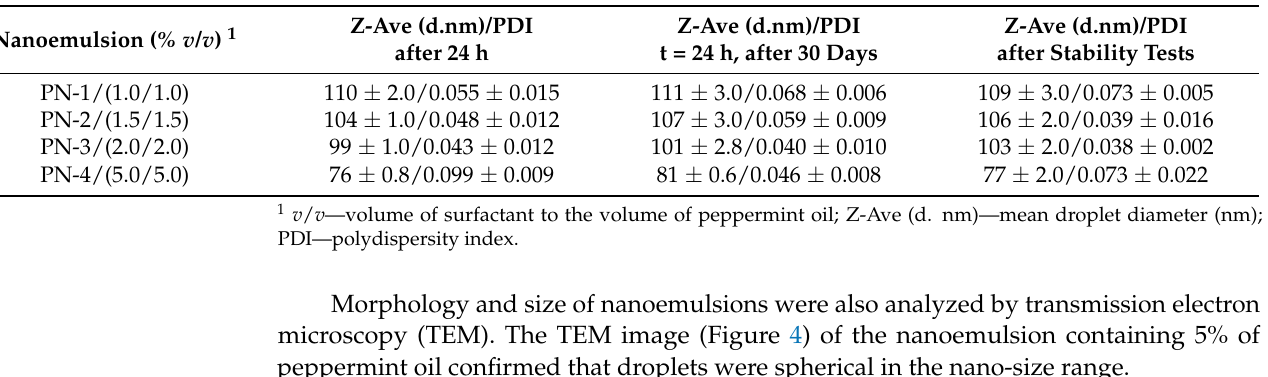
Figure 3. Saddle plots for desirability for essential oil and emulsifier concentration. Table 2. Physicochemical properties of selected nanoemulsions containing different peppermint oil concentrations.